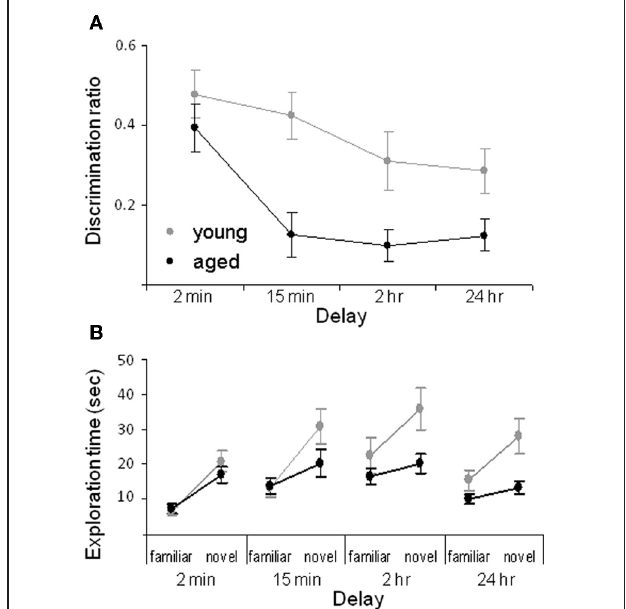
FIGURE 2 | Spontaneous object recognition task performance in young and aged rats. (A) The mean discrimination ratio of the adult (green) and the aged rats (purple) during the test phase for the four different delay conditions. A higher discrimination ratio indicates that the animal spent more time exploring the novel object relative to the familiar object. (B) The mean amount of time young (green) and aged (purple) rats spent exploring the familiar and the novel object during the test phase for the four different delay conditions. Error bars represent ± 1 standard error of the mean (after Burke et al.,